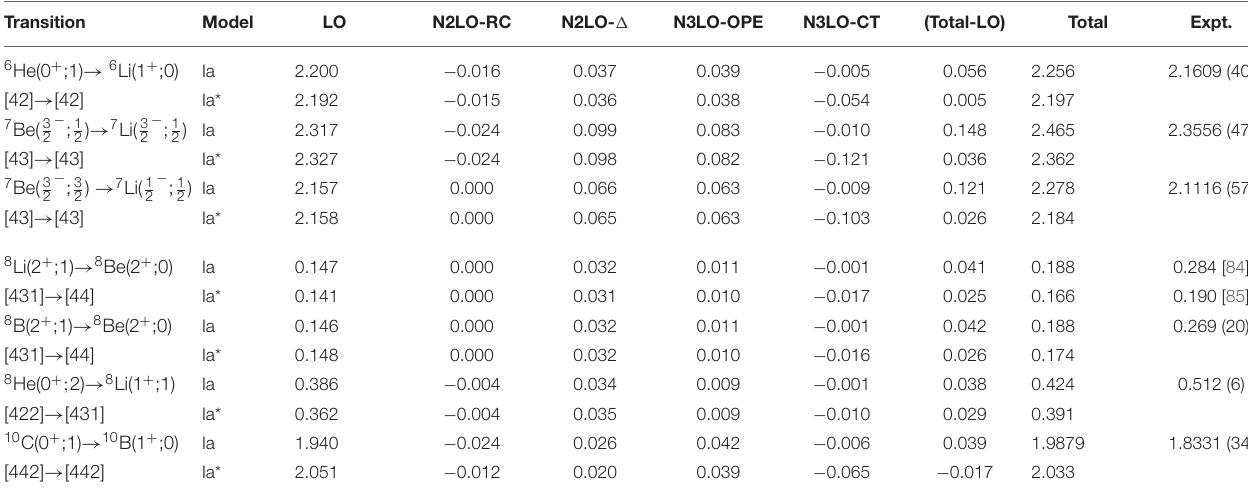
TABLE 2 | Gamow-Teller RMEs in A = 6, 7, 8, and 10 nuclei obtained with chiral axial currents [27] and VMC wave functions corresponding to the NV2+3-Ia/Ia* Hamiltonian models [24, 25, 27, 47]. Transition Model LO N2LO-RC N2LO- 1 N3LO-OPE N3LO-CT (Total-LO) Total